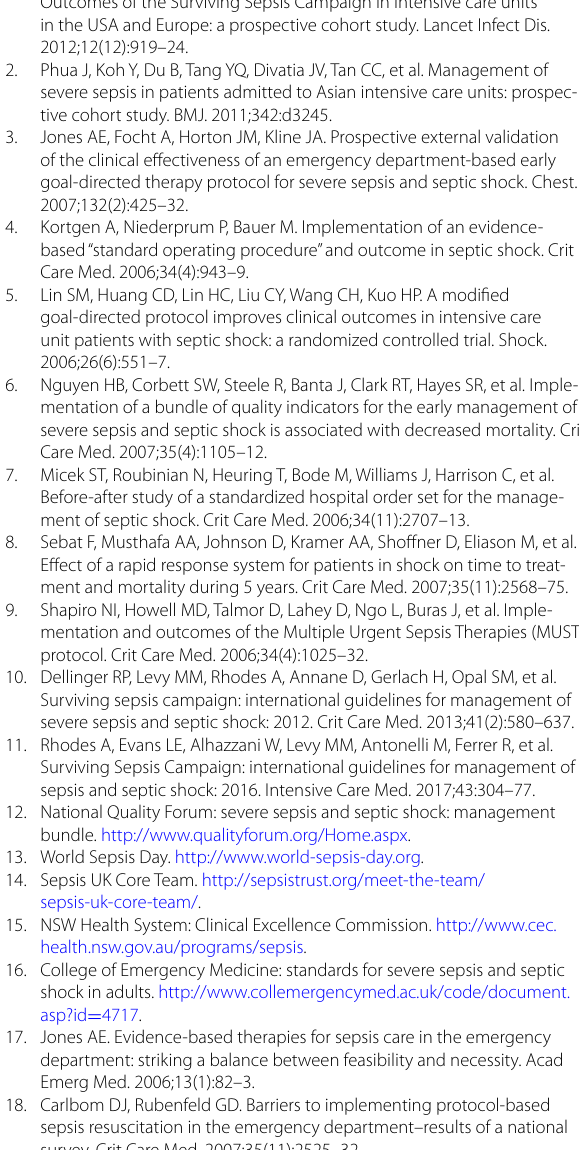
Additional file 1: Figure S1. Sepsis Response Team Clinical Pathway. Figure S2 . Sepsis Response Team Checklist. Table S1 . Sepsis Response Team Policy and